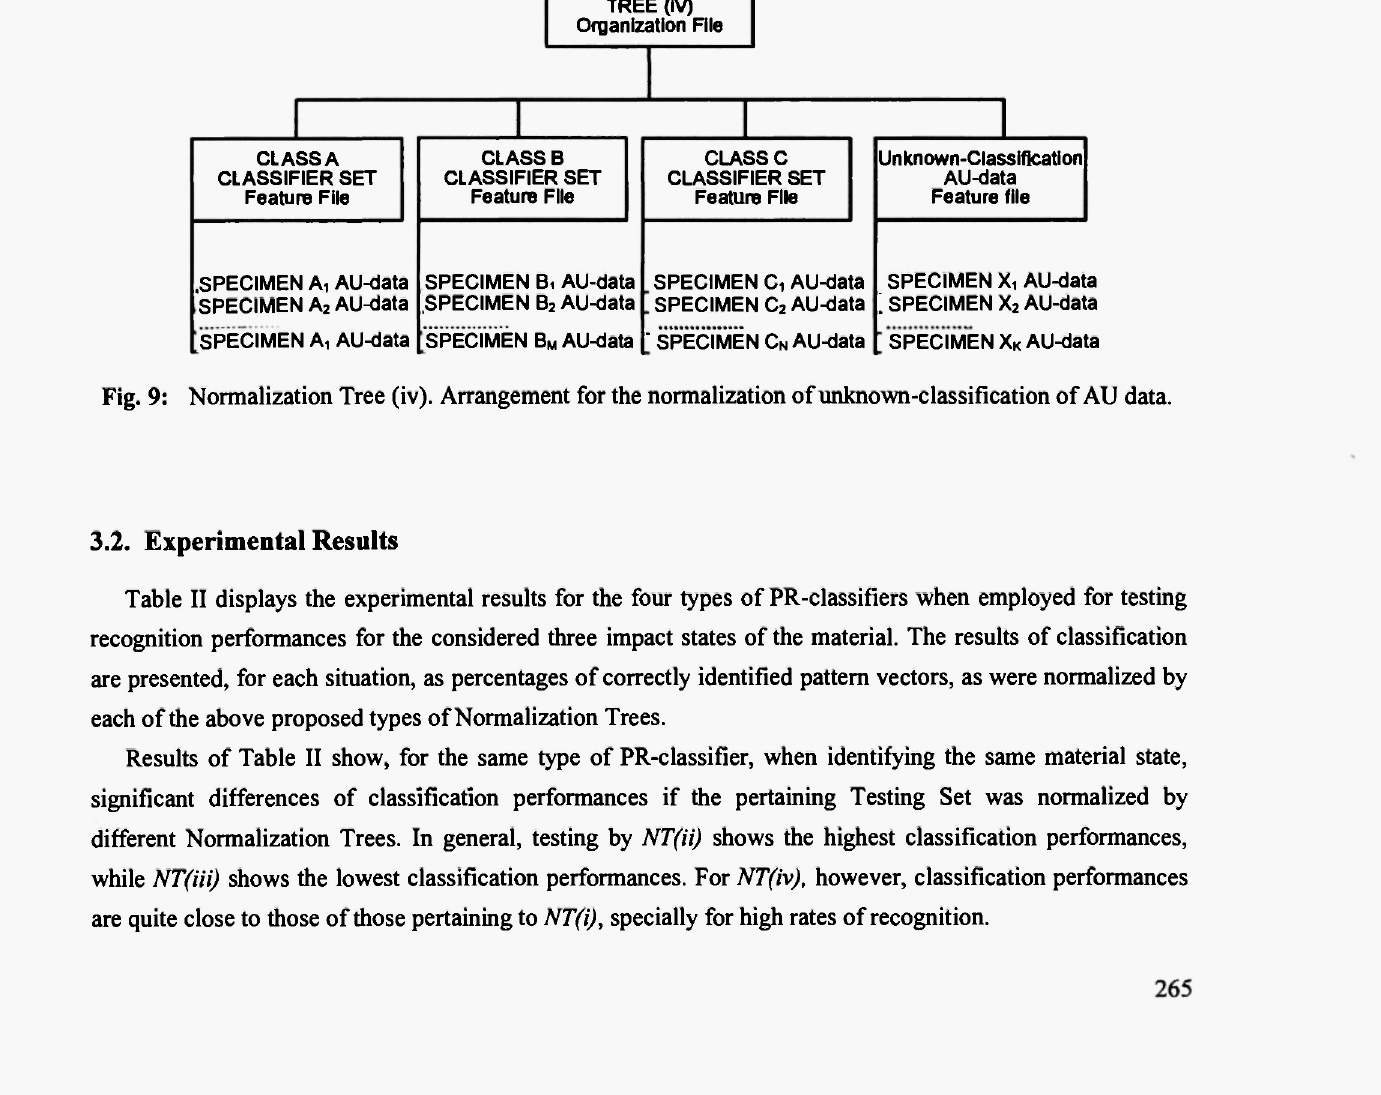
Fig. 9: Normalization Tree (iv). Arrangement for the normalization of unknown-classification of AU